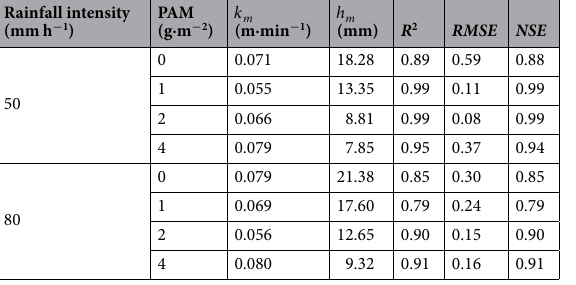
Table 3. The k and h parameters obtained from the model and the R 2 , RMSE and NSE of the measured m m concentration and the simulated